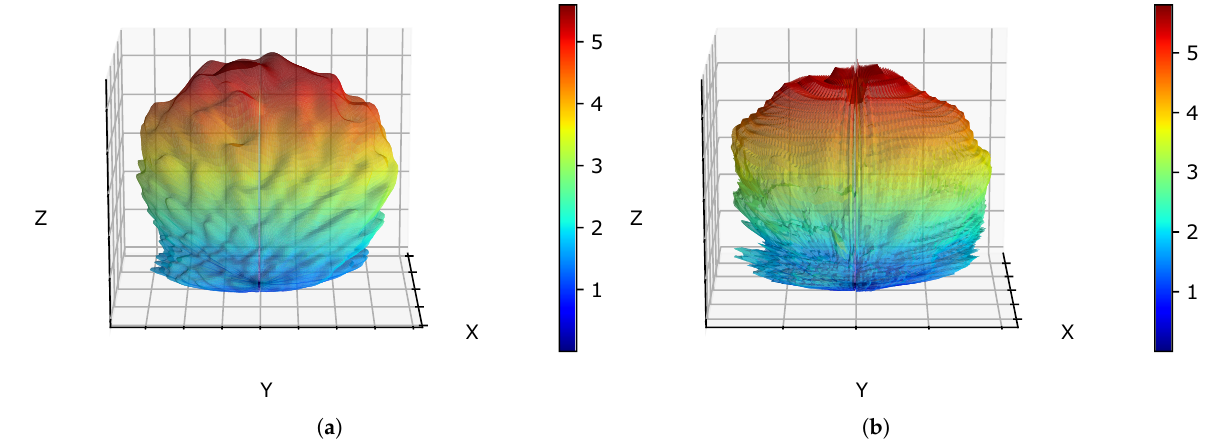
Figure 7. Case study. ( a ) Original RG of P 6 point. ( b) Predicted RG of P 6 point.